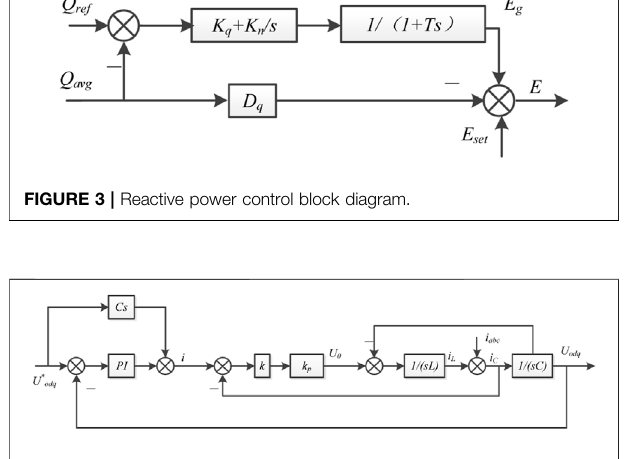
FIGURE 4 | Voltage current double loop control block